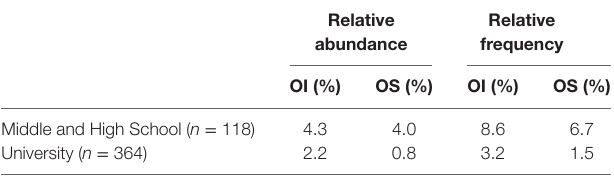
Table 2 | Relative abundance and relative frequency of Instructor Other (OI) and Student Other (OS) codes in middle and high school classes and university level